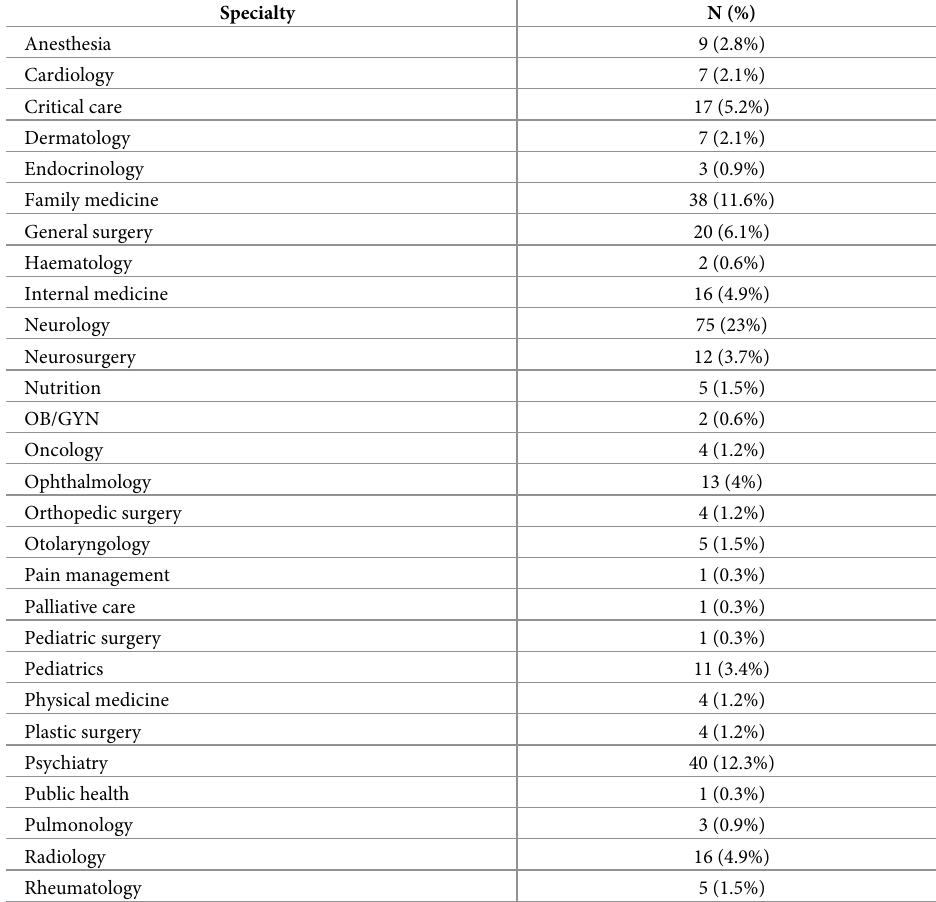
Table 2. Distribution of the studied cases according to the different specialties (n =